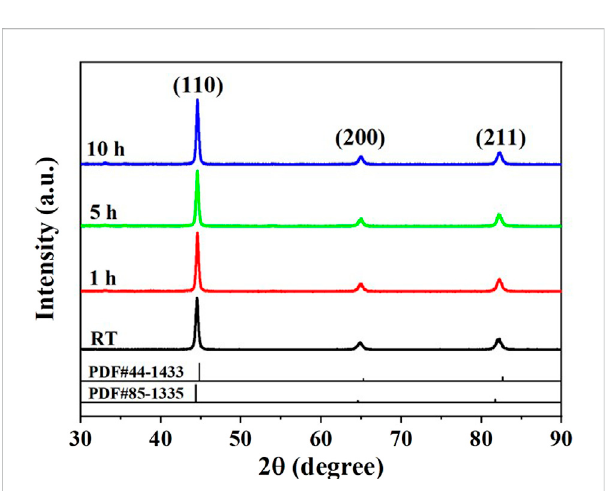
FIGURE 2 XRD spectra of FeCoCr powders after heat treatment at 400 ° C for different time.